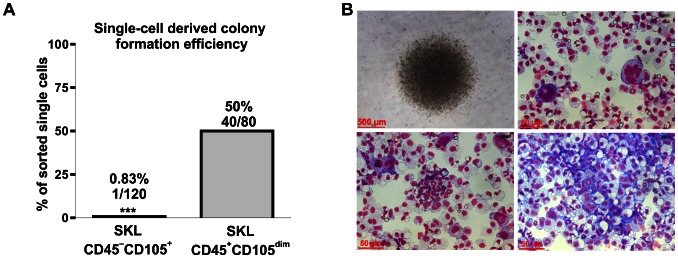
Verification of hematopoietic potential of SKL CD45−CD105+ and SKL CD45+CD105dim cells.(A) Quantitative analysis of colony formation efficacy by SKL CD45−CD105+ and SKL CD45+CD105dim (positive control) cells in single cell-derived colony in vitro assay. (B) Representative colony formed by SKL CD45+CD105dim cells (contrast-phase microscopy and Wright’s staining) with cells derived from different hematopoietic lineages evidenced presence of multipotent hematopoietic cells among SKL CD45+CD105dim population.